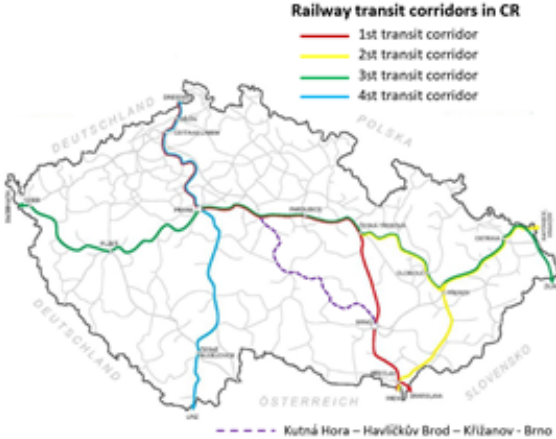
Figure 3. Railway transit corridors in Czech Republic.